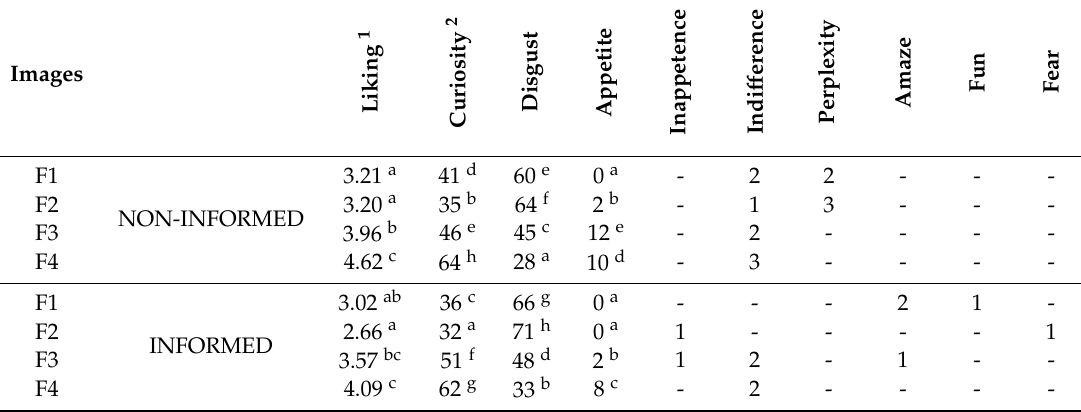
Table 3. Impacts of edible insect product images on liking and frequency of evoked emotions.